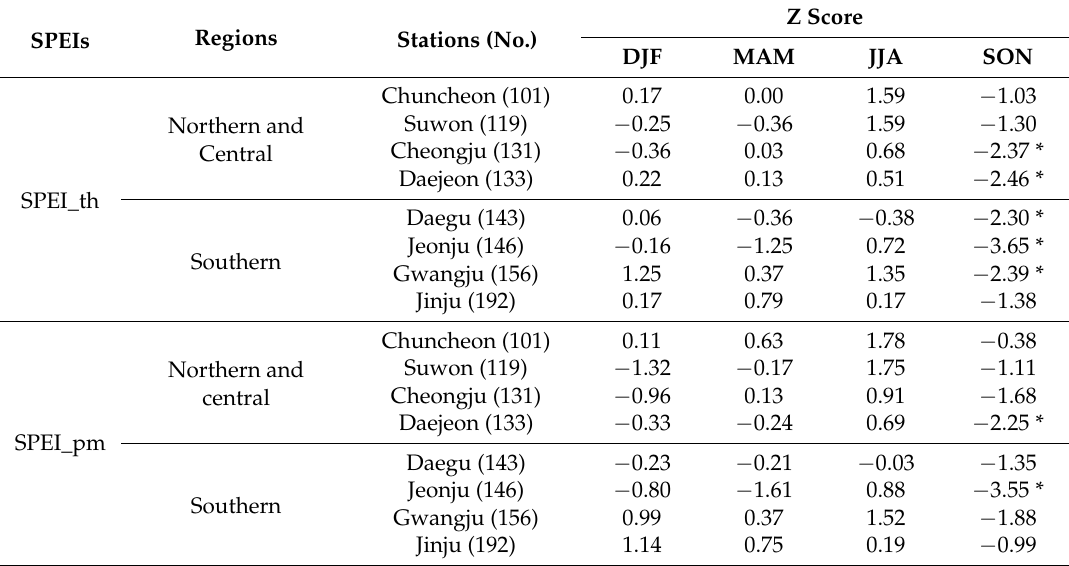
Table 4. The results of the Mann–Kendall (MK) trend test for 1-month SPEI_th and SPEI_pm.